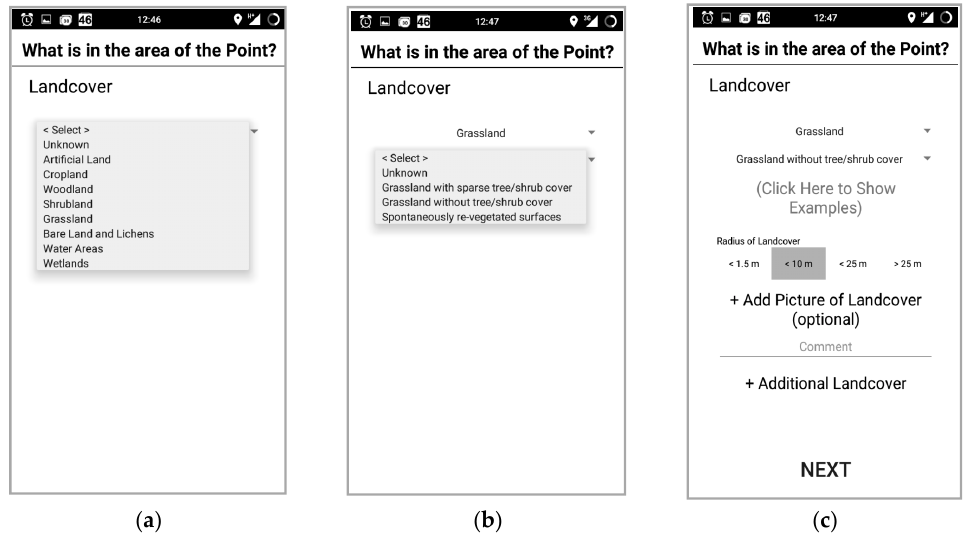
Figure 3. Screenshots from the FotoQuest Austria app showing: ( a ) land cover choices at level 1; ( b ) land cover choices at level 2, which are dependent upon the choice made at level 1; and ( c ) the radius of homogeneous land cover, with the option to add a picture.